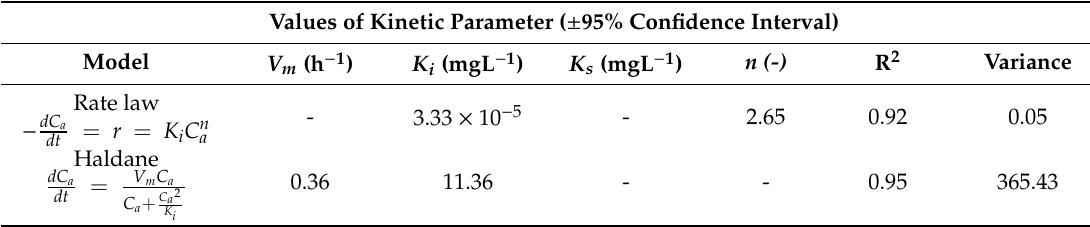
Table 2. Estimated values of kinetic parameters for the models for CN −